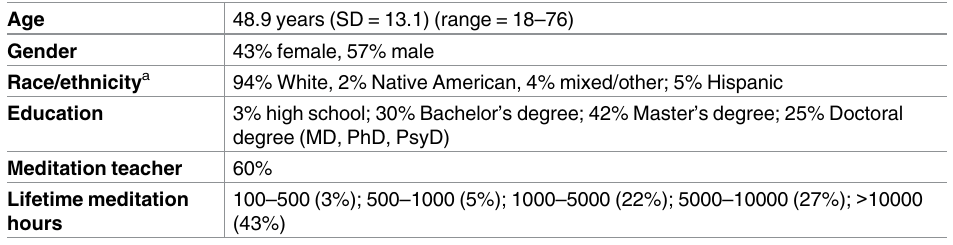
Table 1. Practitioners’ demographic information.